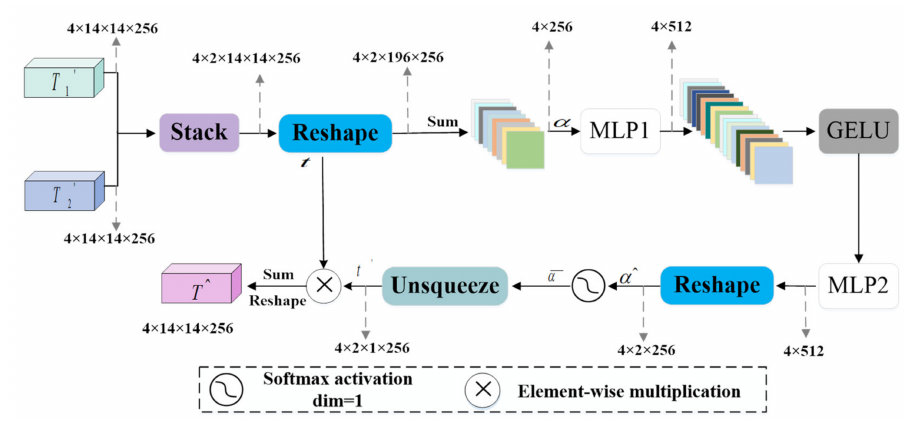
Figure 4. Split Attention module.